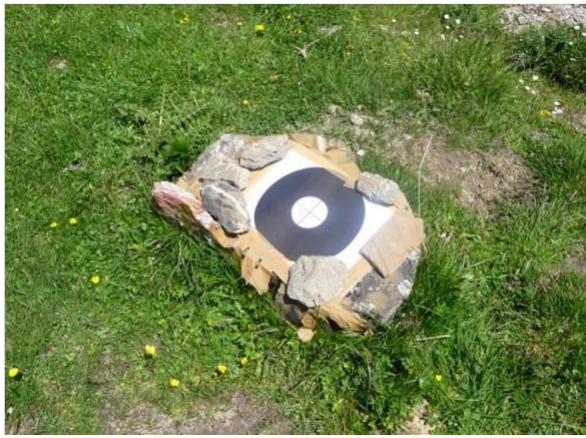
Figure 6: Ground Control Points for UAV Acquisition